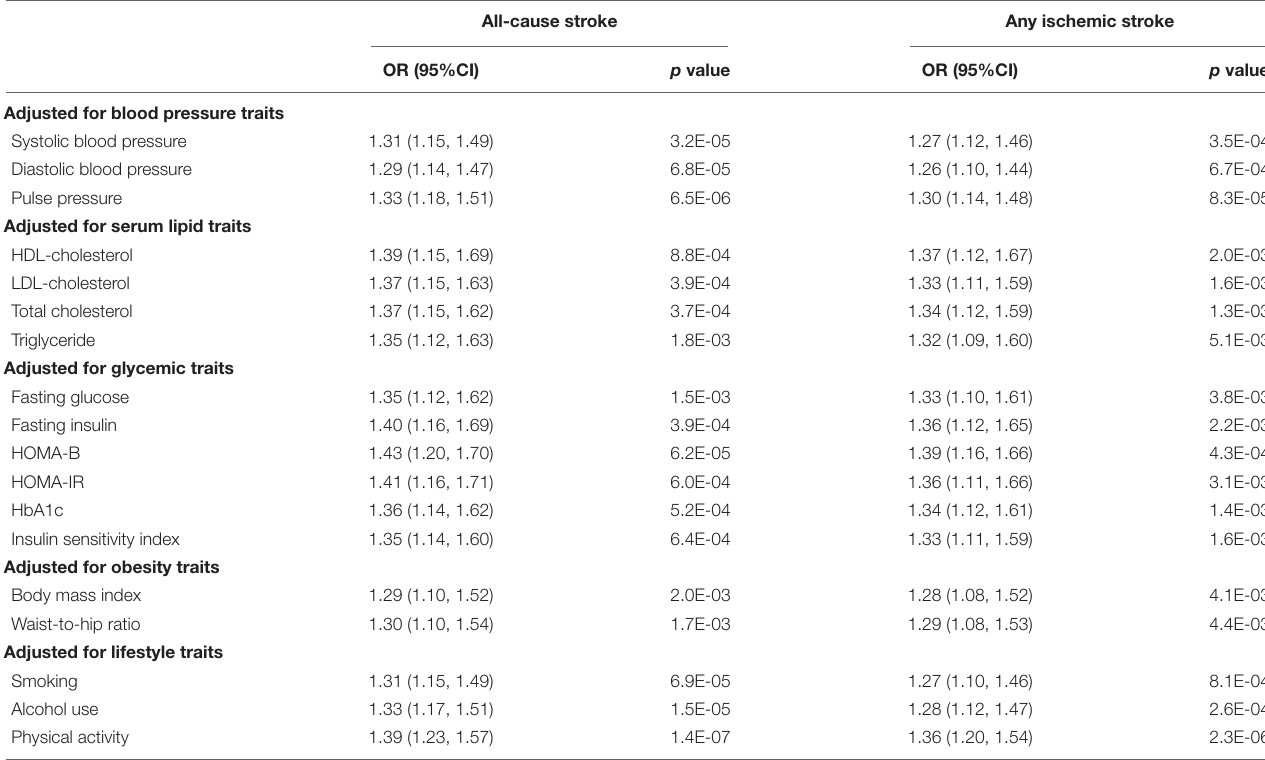
TABLE 2 | Multivariable Mendelian randomization of genetically determined television watching and stroke adjusted for confounding traits. All-cause stroke Any ischemic stroke